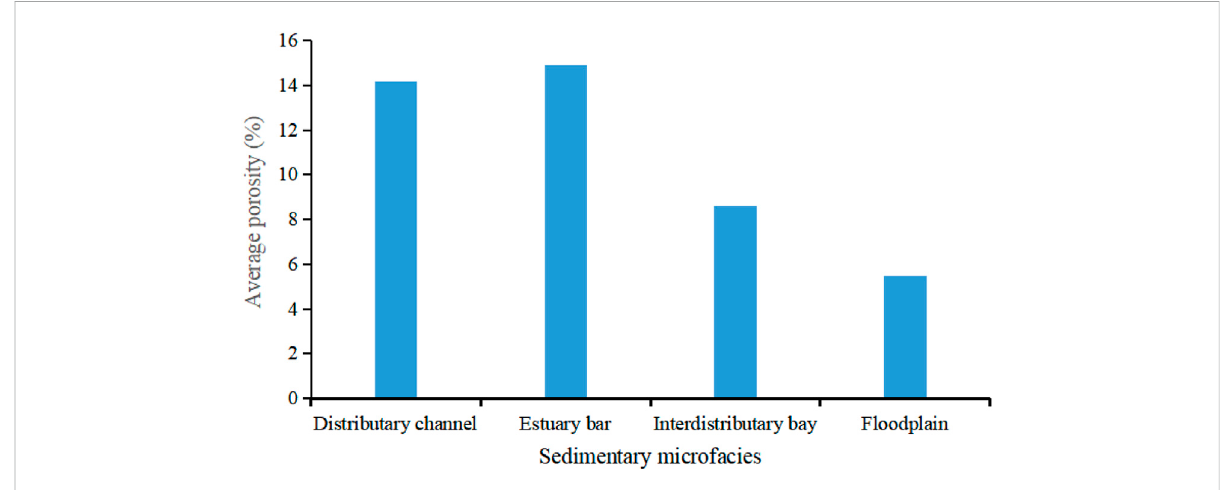
FIGURE 7 Histogram of average porosity distribution of different sedimentary